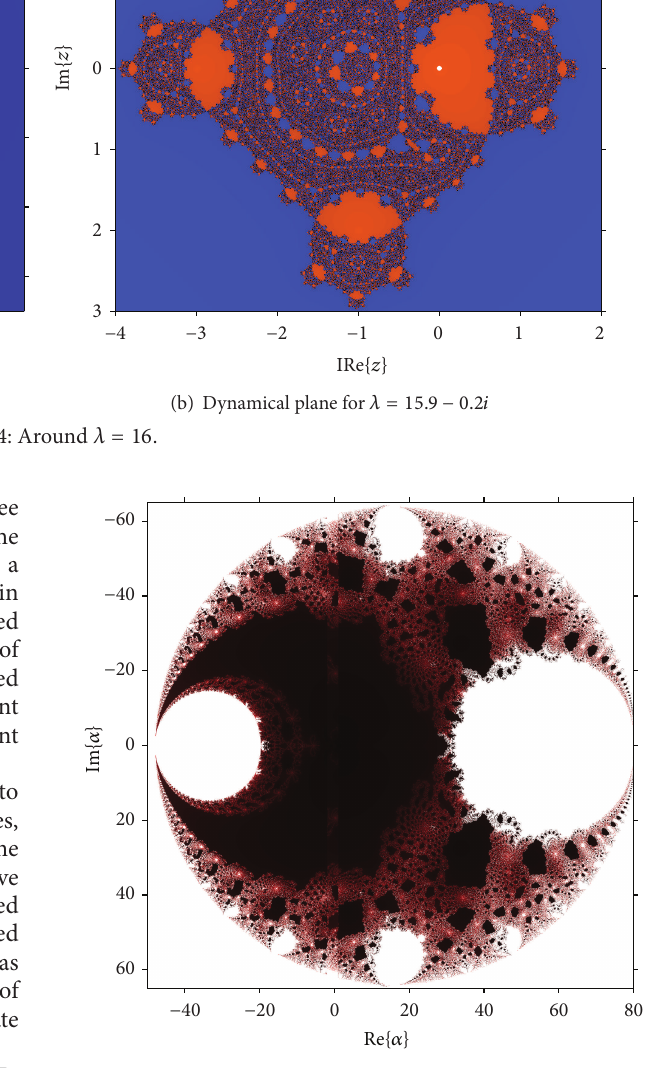
Figure 5: Parameter space 𝑃 2 associated with 𝑧 = cr 𝑖 , 𝑖 = 3, 4